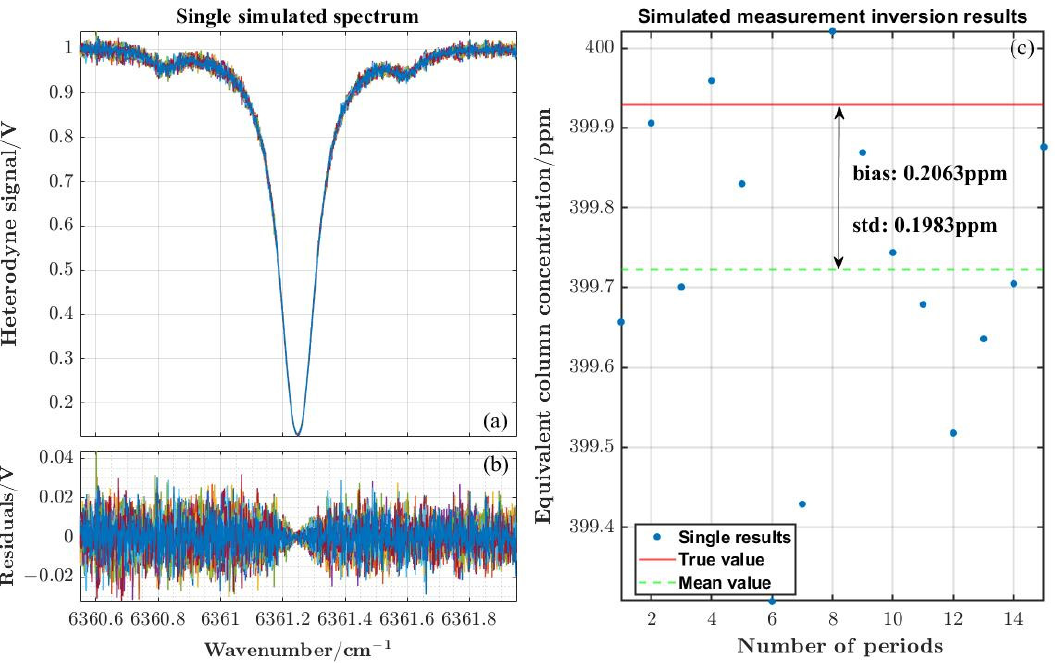
Figure 8. ( a ) The simulated multiple heterodyne-signals based on the SNR of 100. ( b ) The residuals between multiple heterodyne-signals. ( c ) Retrieval results of multiple between multiple heterodyne-signals. ( c ) Retrieval results of multiple heterodyne-signals.